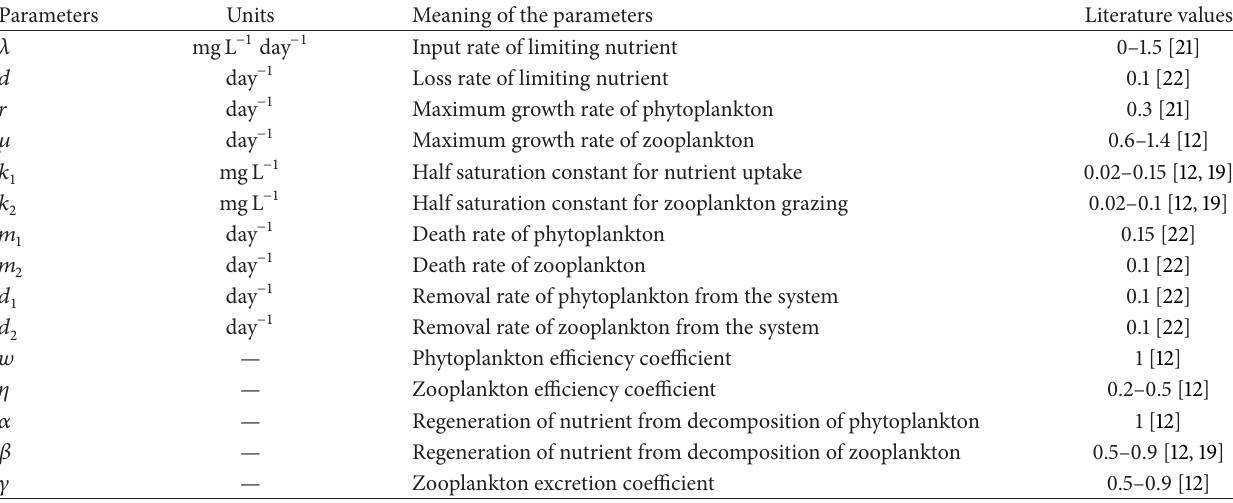
Table 1: System parameters and ranges of their values used in the